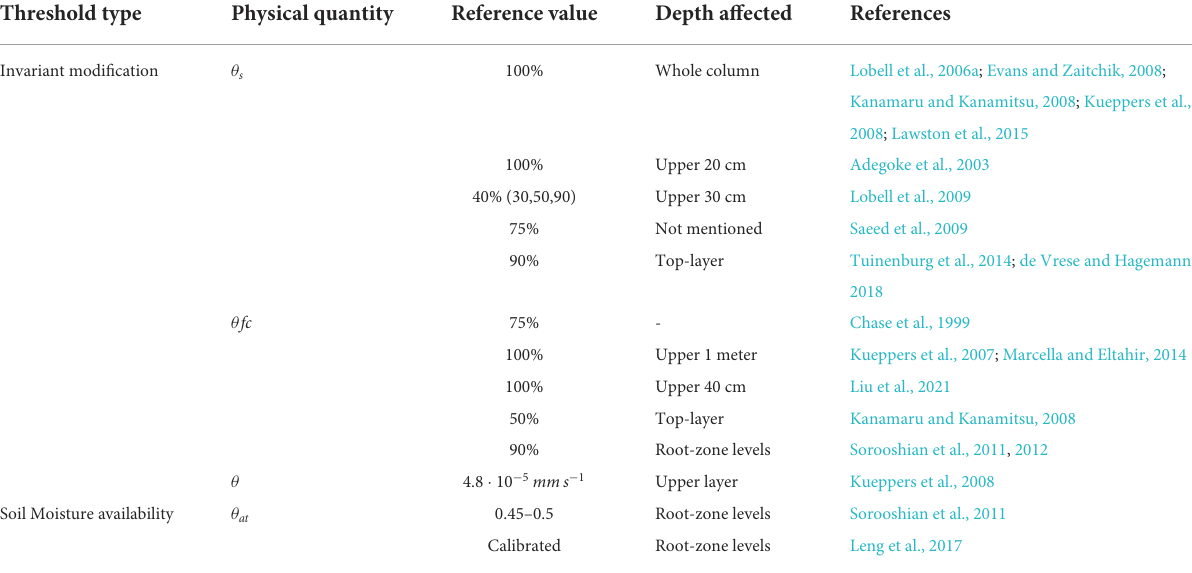
TABLE 3 Summary of parameterizations with irrigation implemented as soil moisture